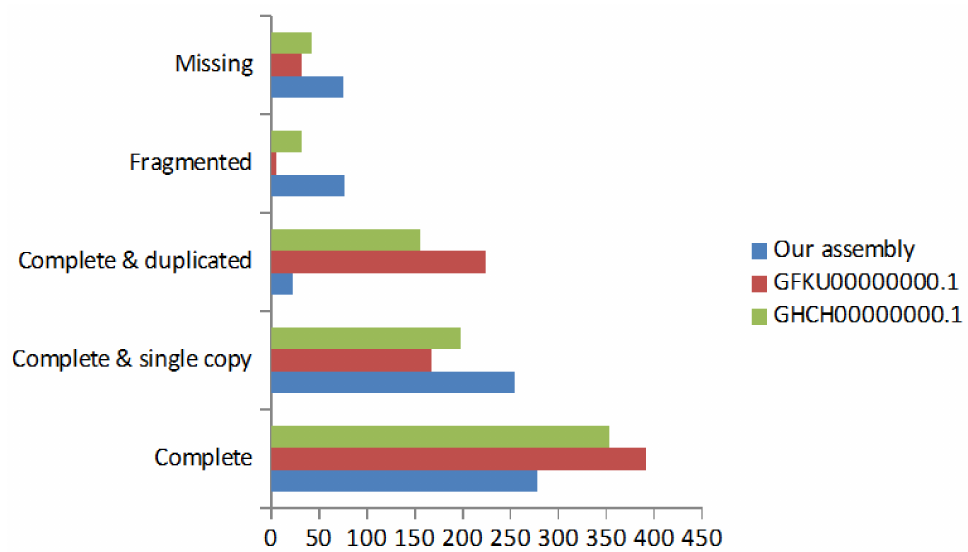
Figure 2. Comparison of BUSCO results among three assemblies. Quantitative assessment of transcriptome completeness for the newly assembled wild cucumber transcriptome, and comparison with related publicly available transcriptome assemblies.